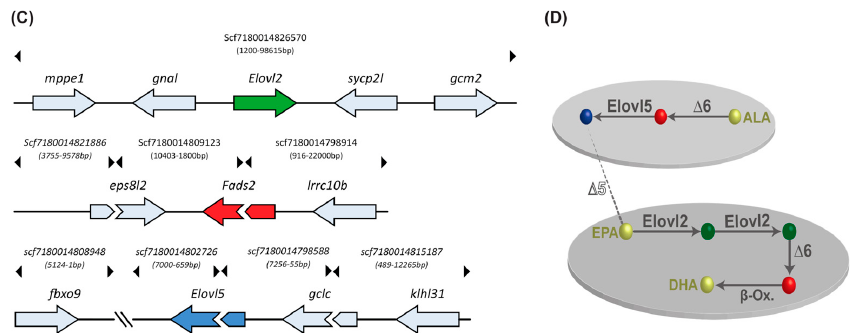
Figure 3. Maximum likelihood phylogenetic analysis of fads2 ( A ) and elovl orthologues ( B ) analyzed in the present study: Clupeiformes species are highlighted, node numbers indicate bootstrap values. ( C ) Reconstructed genomic loci of fads2 , elovl2 , and elovl5 denote synteny conservation between the European sardine and Atlantic herring: scaffold coordinates and identified neighbouring genes are indicated; broken lines and arrows denote reconstruction from overlapping scaffolds. ( D ) LC-PUFA biosynthesis pathway in the European sardine, dashed line indicates the Δ 5 desaturation capacity absent in the European sardine, n-3 fatty acids are indicated in yellow: ALA— α -Linolenic acid (18:3n-3), EPA—eicosapentaenoic acid (20:5n-3) and DHA—docosahexaenoic acid (22:6n-3).